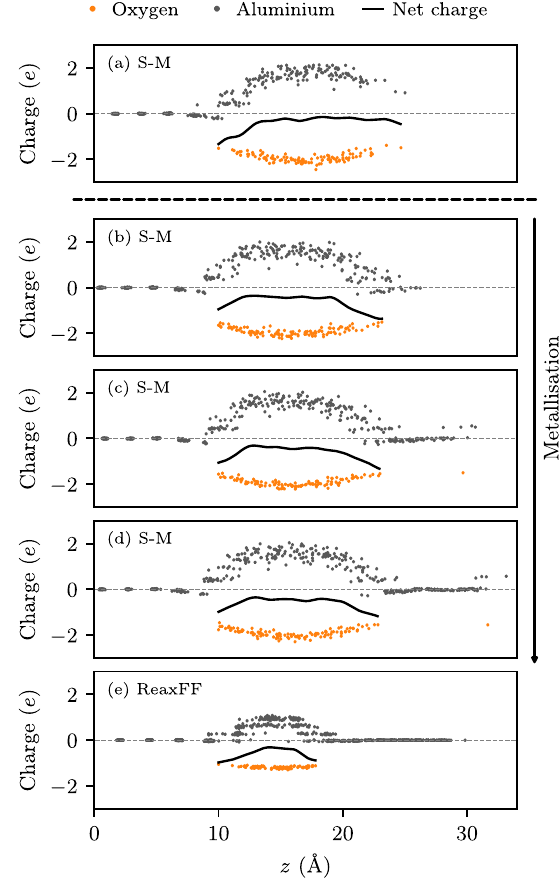
Fig. 12 Partial charges in the structure at varying stages of metallisation. The partial charges of oxygen and aluminium atoms are shown as orange and grey dots, respectively. The black lines show the net charge in the structure is as a function of z . a The initial oxidised aluminium surface. b – d Continued metallisation with the S – M potential. e Partial charges in the fi nal junction structure formed with the ReaxFF